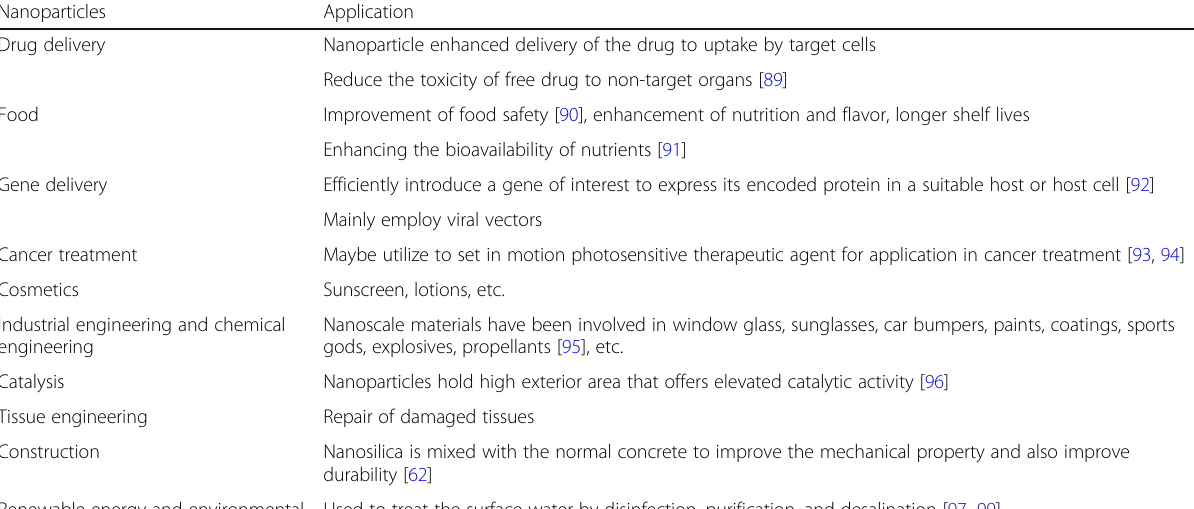
Table 3 Application of nanoparticles in various fields